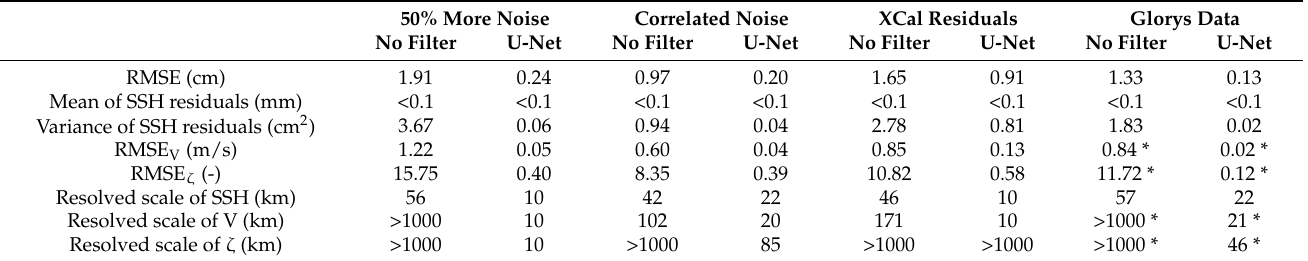
Table 3. Offshore (>10 km to the coast) scores of four scenarios. The scores before denoising are also indicated for each scenario. The scores are calculated on the entire